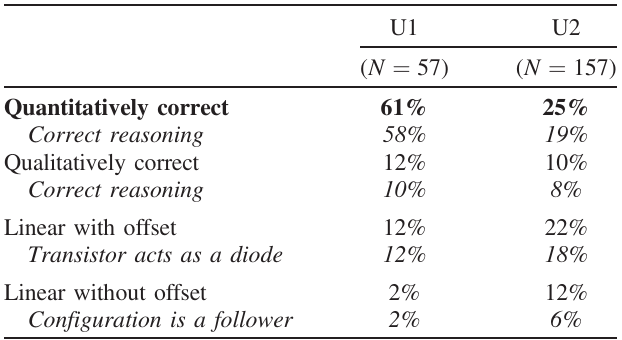
TABLE III. Overview of student performance on the follower voltage graphing task (shown in Fig. 5). Quantitatively correct responses are indicated by bold